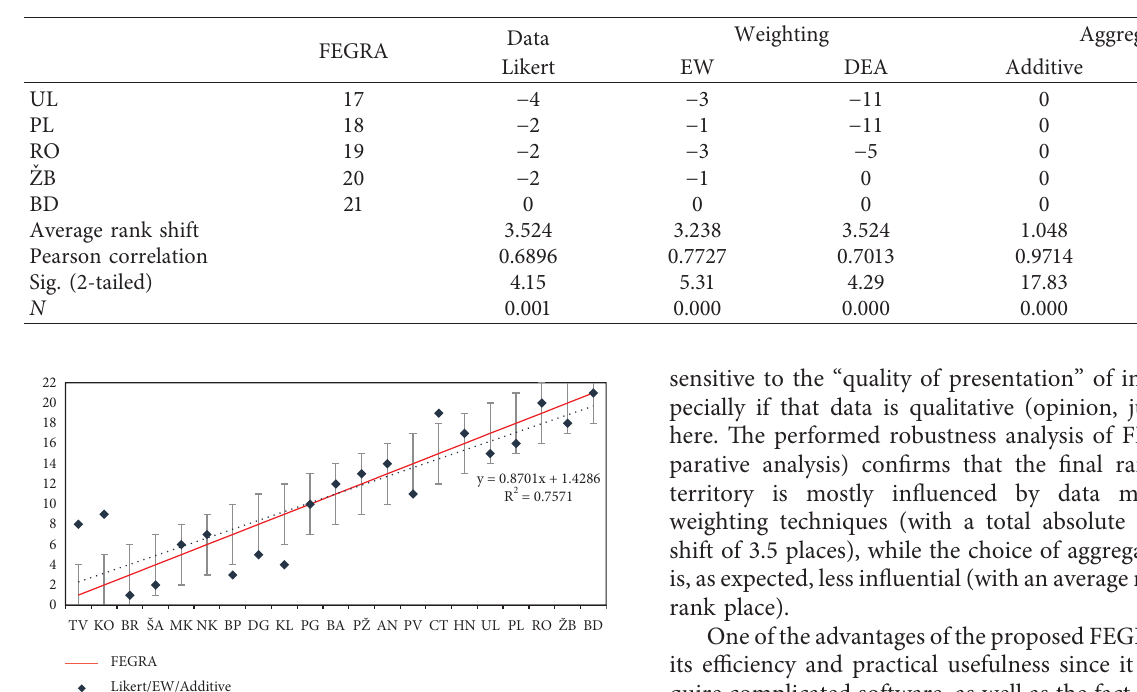
Figure 5: Final ranking